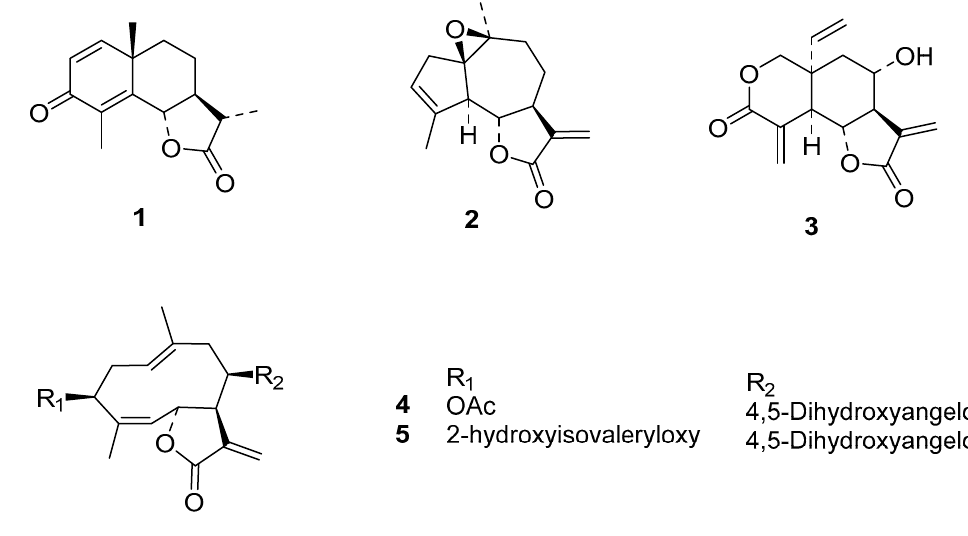
Figure 3. Sesquiterpene lactones used in this study.